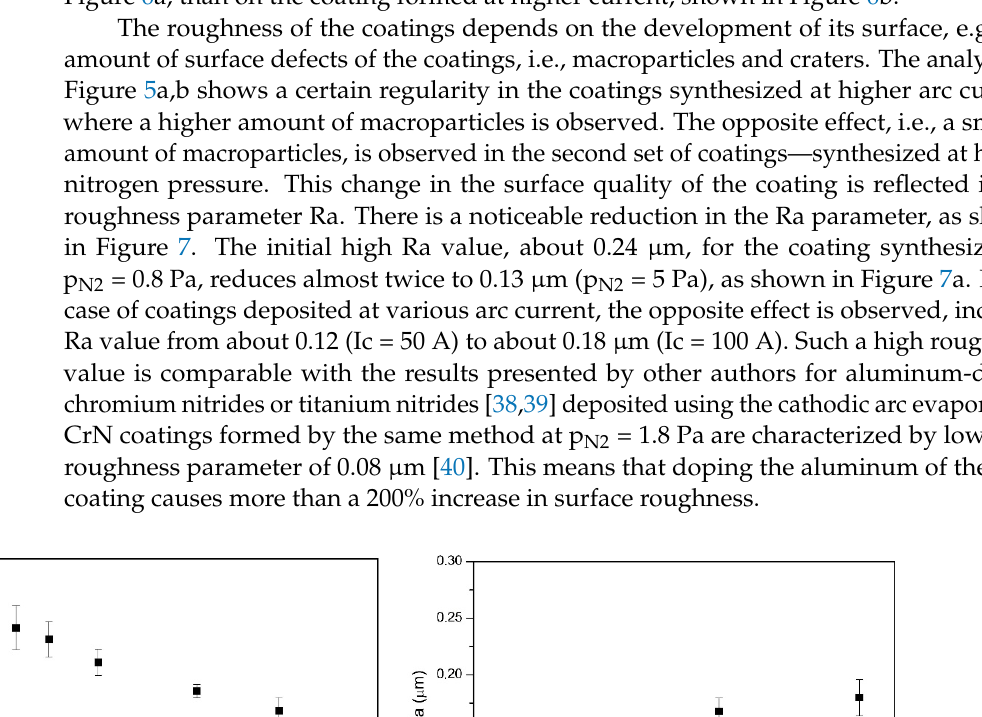
Figure 6. Morphology of of AlCrN coatings synthesized at: ( a ) Ic = 50 A and ( b ) Ic = 100 A. Each picture shows the area recorded at magnification: 1000 × ( bottom ) and 3000 × ( top ).